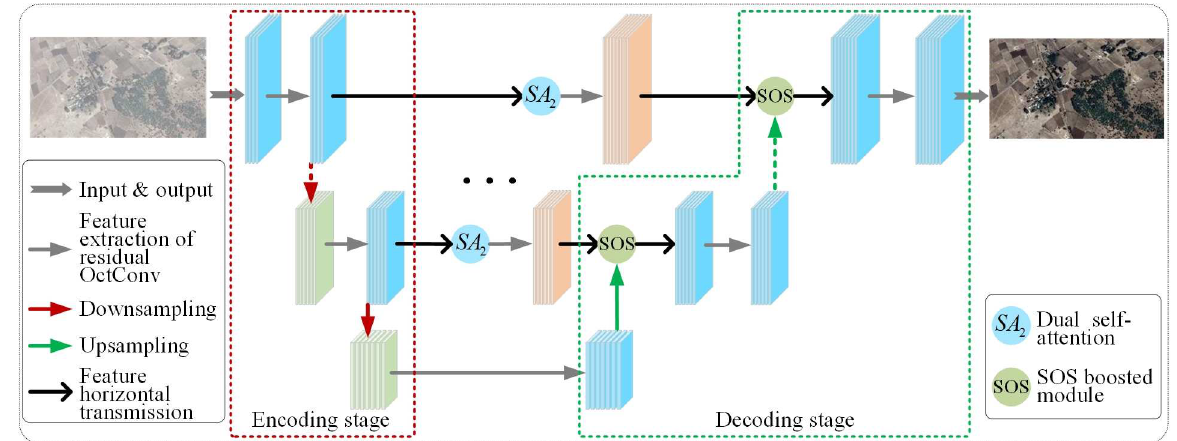
Figure 1. Overall network architecture. The networks have four downsamplings and four upsamplings in total. In each layer of encoding and decoding (in the first four layers of the networks), the feature maps of the encoding stage are passed to the decoding stage in the same way. The feature map of each layer of encoding stage is first processed by dual self-attention to obtain the feature map after feature enhancement, and then the feature map and the feature map in the decoding stage of the next layer after upsampling are input into the SOS boosted module, thereby realizing the effective fusion of image feature information. The feature transfer method of encoding-decoding in the last layer is only processed by convolution operations. The fused feature map is sent to the next convolution operation and then upsampled. Finally, the feature map after the last feature fusion is restored to a fog-free